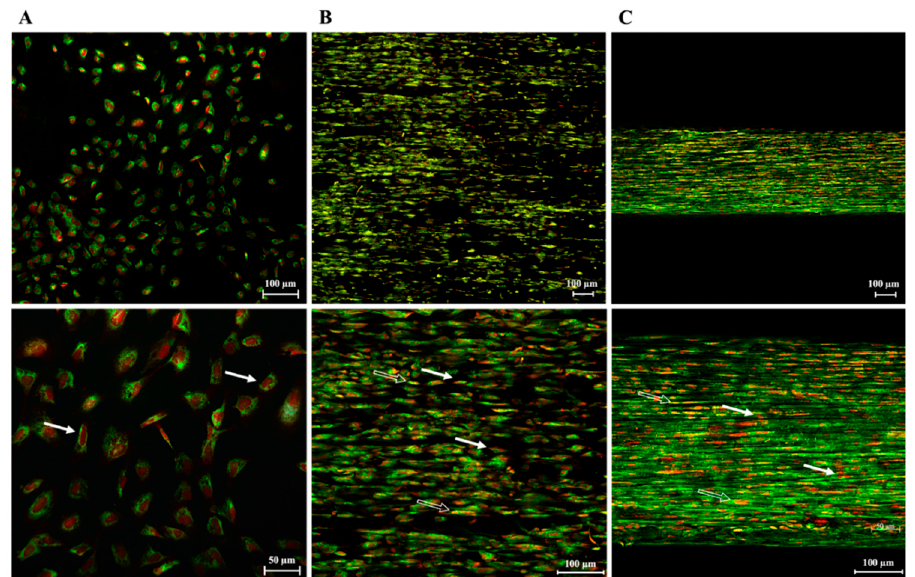
Figure 11. IF analysis of YAP protein expression (green fluorescence) and localization in ( A ) AECs cultured on Petri dishes (CTR) or seeded on PLGA ( B ) fleeces and ( C ) 3D. PI (red fluorescence)- counterstained nuclei. While CTR cells expressed the protein only within the cytoplasm, cells cultured on fleeces and 3D scaffolds localized YAP within the cytoplasm and in the nucleus (yellow nuclei, due to the overlap of red and green fluorescence). Examples of YAP cytoplasmic localization (white arrows) and nuclear translocation (white plain arrows).